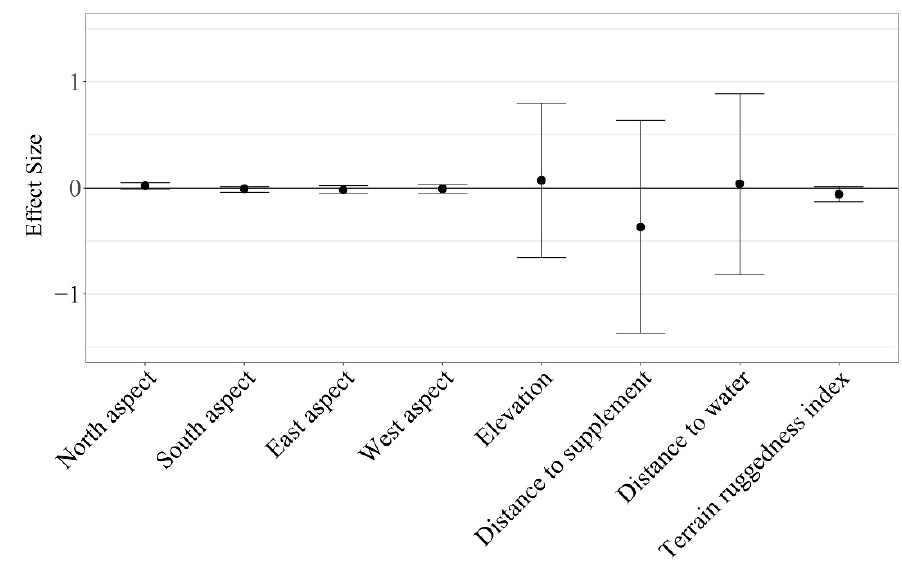
Figure 6. Mean standardized herd-level effect size (ˆ β ± 95% CI) for cattle grazing dormant northern mixed-grass prairie in 2018/2019 and 2019/2020 at the Northern Agriculture Research Center’s Thackeray Ranch, Havre, MT, USA.